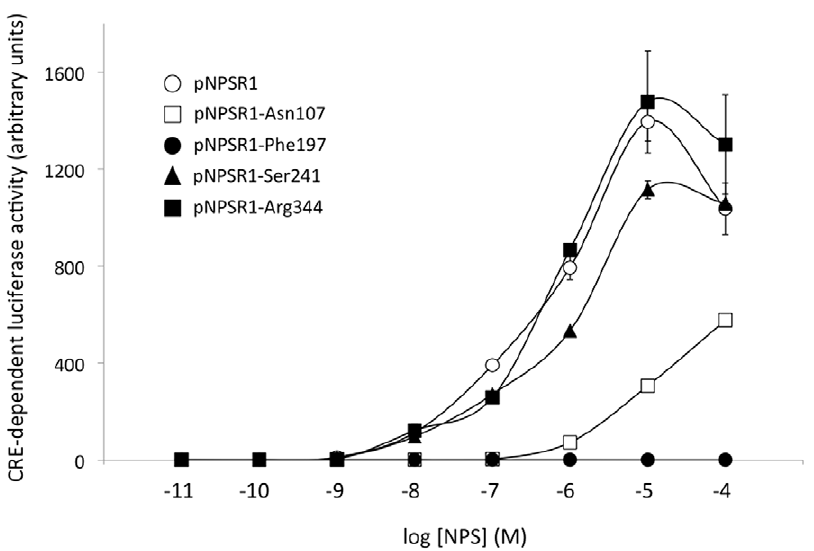
Figure 4. Pharmacological activity of NPSR1 coding variants. Dose-response curves of NPS stimulation, in HEK293 cells transiently co- transfected with a CRE-luc plasmid and NPSR1 coding variants in triplicate, as indicated. One representative experiment is reported, where CRE-driven